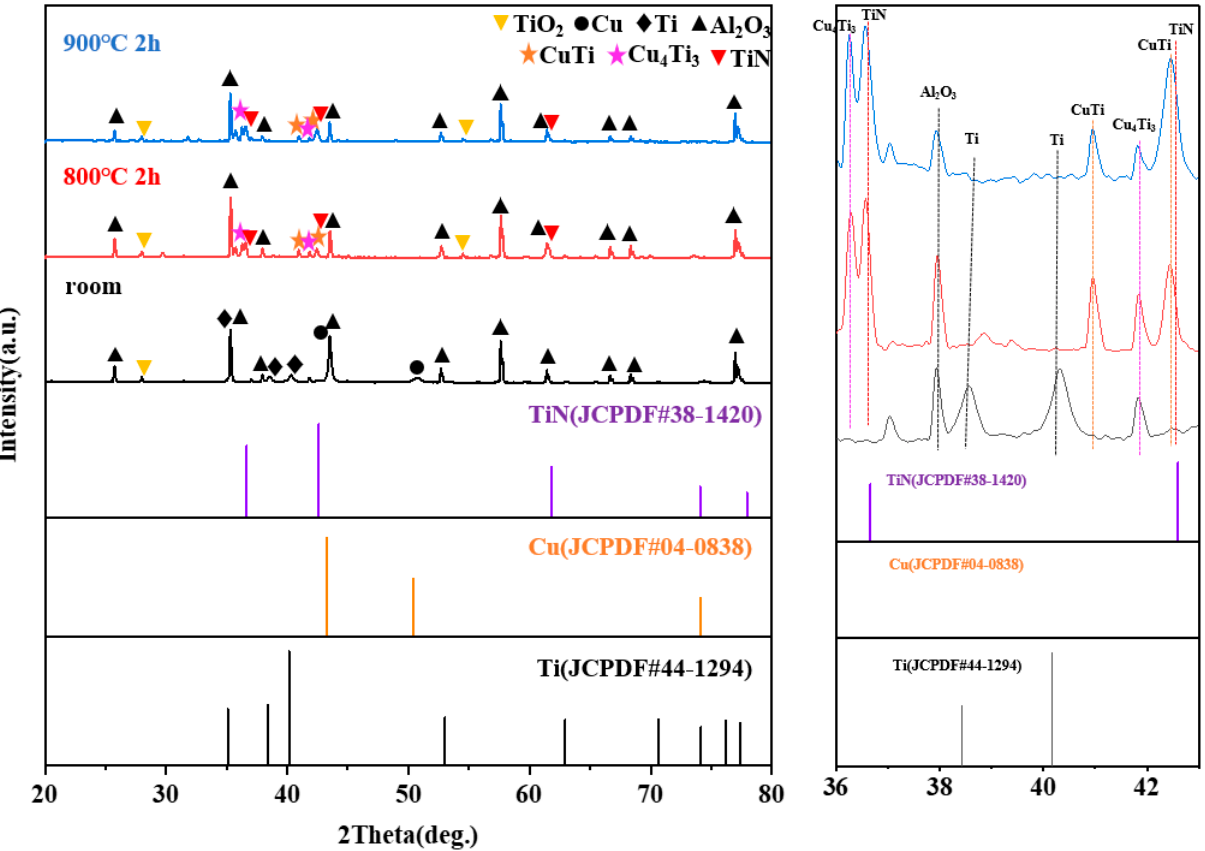
Figure 2. The XRD patterns of the Ti/Cu multilayer film before and after nitriding.